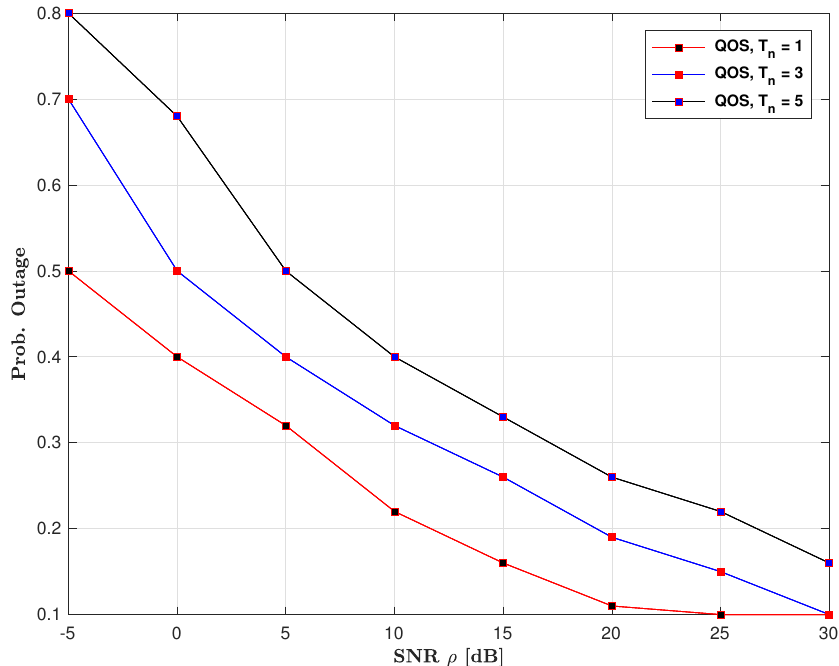
Figure 12. Plot Probability of outage with the SNR= p k / σ 2 , comparing QoS